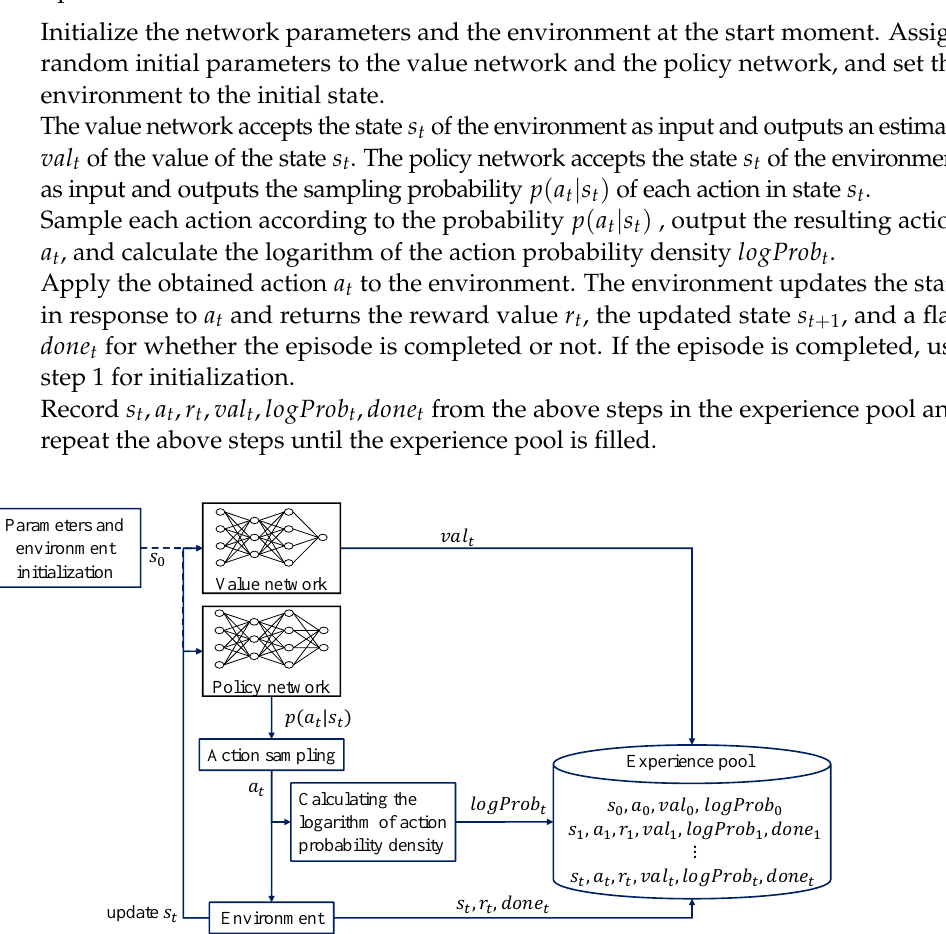
Figure 7. Environment exploration and experience gathering